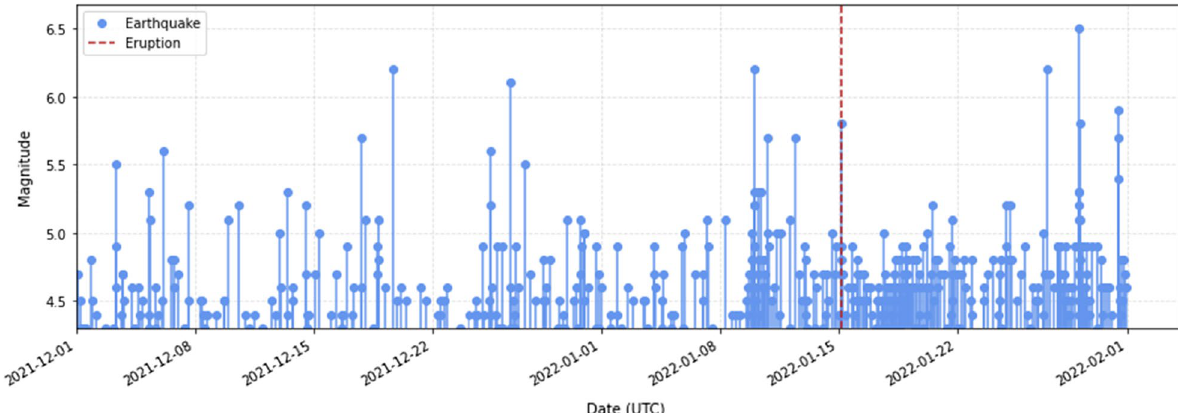
Fig. 5 There were 529 earthquakes around Tonga (170.0E, 160.0 W, 10.0 S, 45.0 S) between 1 December 2021 and 31 January 2022